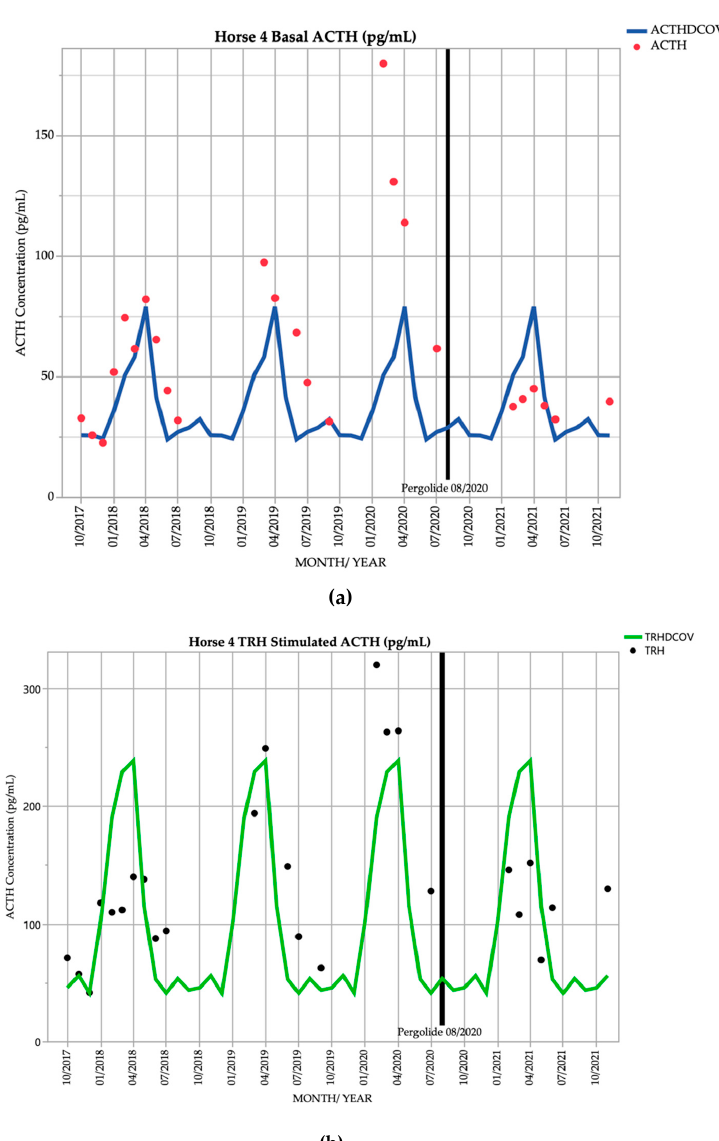
Figure 4. Monthly ACTH concentration (pg/mL) in Horse 4 (21 ‐ year ‐ old Stockhorse gelding), com ‐ pared to locally derived, seasonally adjusted DCOV [2]. (a) Basal ACTH concentrations (red points) and basal ACTH DCOV (blue line) (b) TRH ‐ stimulated ACTH concentrations (black points) and TRH ‐ stimulated ACTH DCOV (green line).